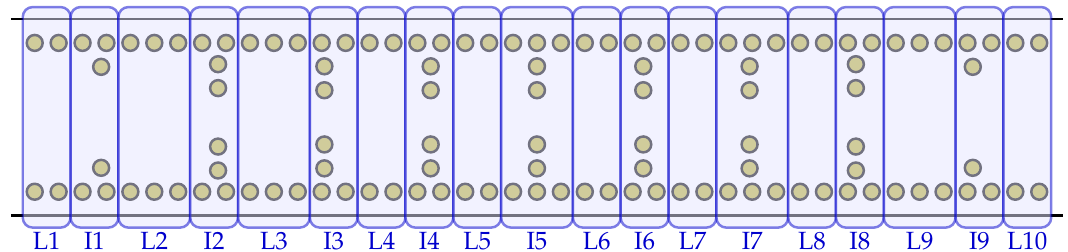
Figure 13. Eight coupled-cavity SIW filter. Segmentation into constitutive blocks (empty lines, and